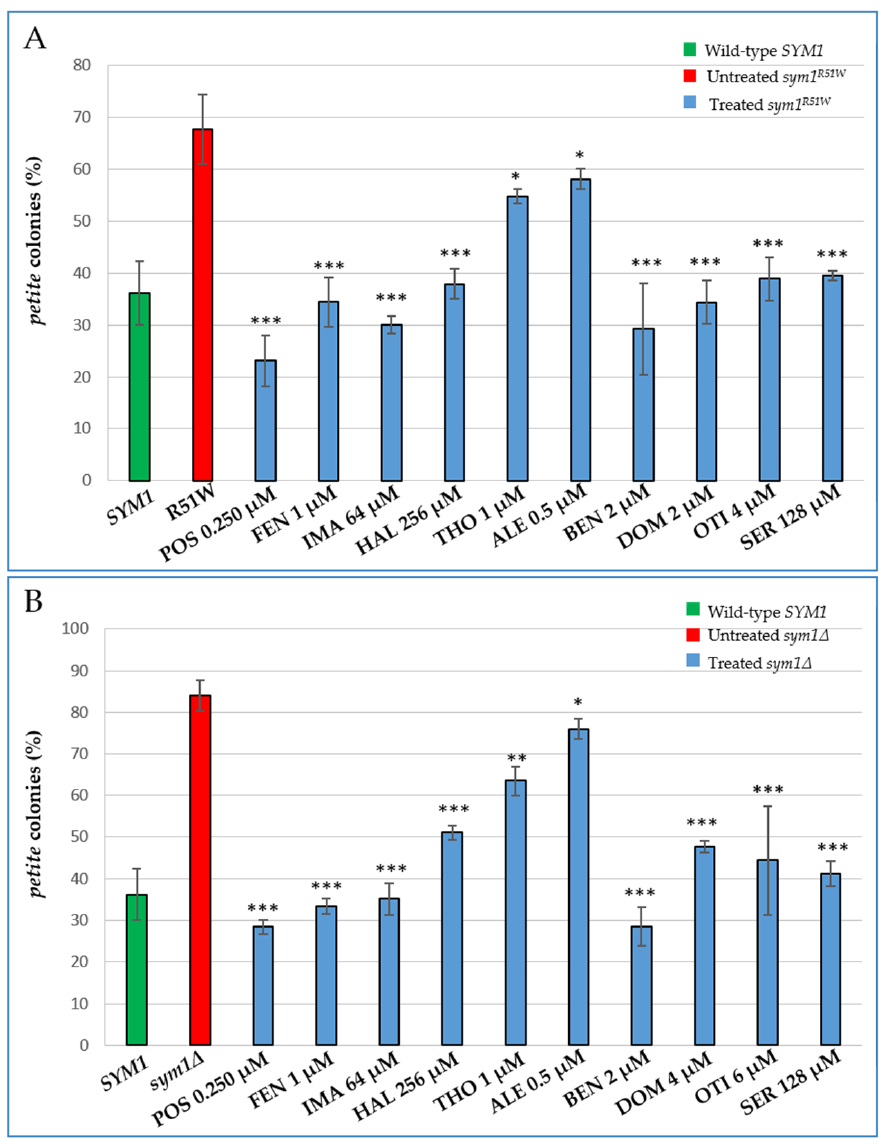
Figure 2. Effect of the identified drugs on petite frequency of the sym1 R51W ( A ) and sym1 ∆ mutant strains ( B ). Cells were grown at 37 ◦ C in synthetic complete (SC) medium supplemented with 2% glucose and 2% ethanol. More than 4000 colonies/strain were scored. Values are represented as the mean of at least three independent experiments ± standard deviation (SD). Statistical analyses were performed using one-way analysis of variance (ANOVA) followed by a Bonferroni’s post hoc test comparing treated (blue bars) versus the untreated mutant (red bar) in which the compound vehicle DMSO was added: * p < 0.05; ** p < 0.01; *** p <